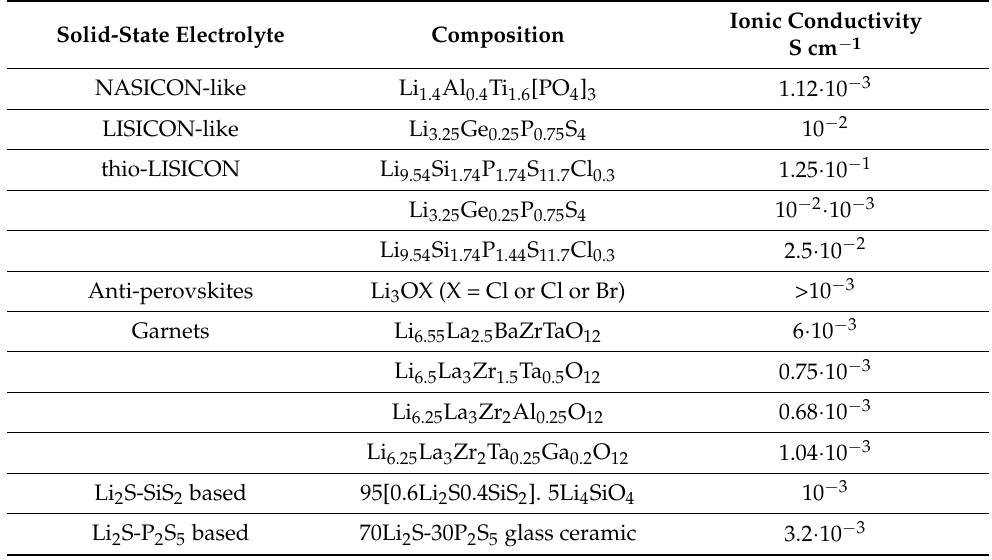
Table 3. Ionic conductivity of solid inorganic electrolytes at room temperature. Solid-State